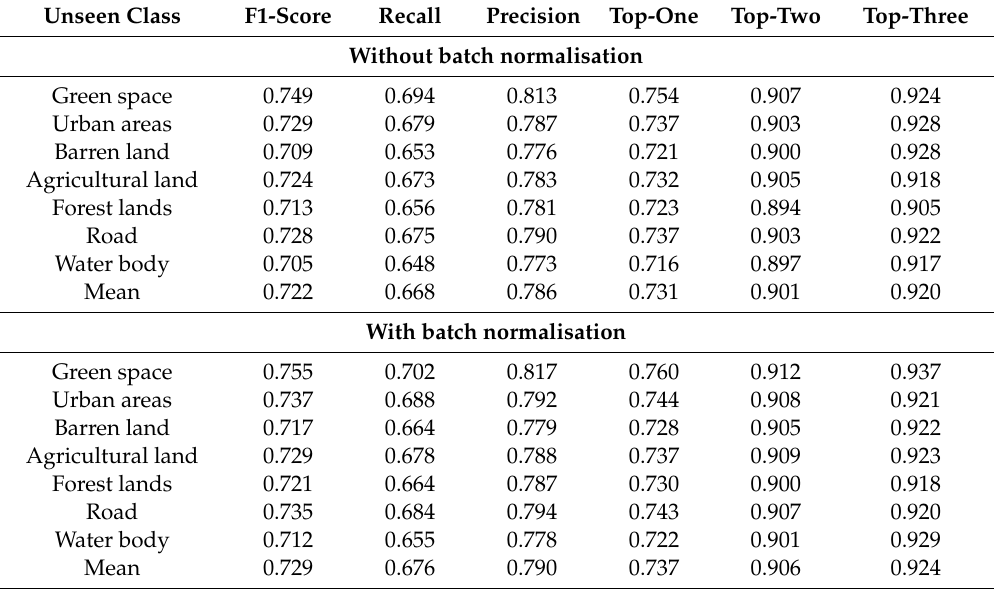
Table 9. Accuracy of the model without and with batch normalisation for the second test area (Ipoh). Unseen